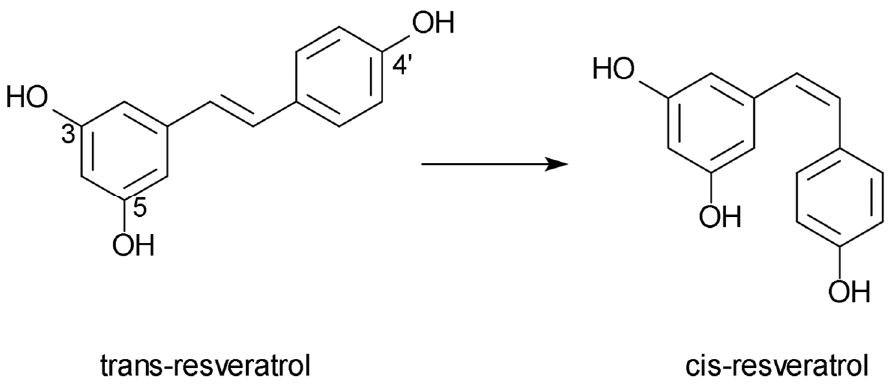
Figure 1. The chemical formula of trans- and cis-resveratrol.